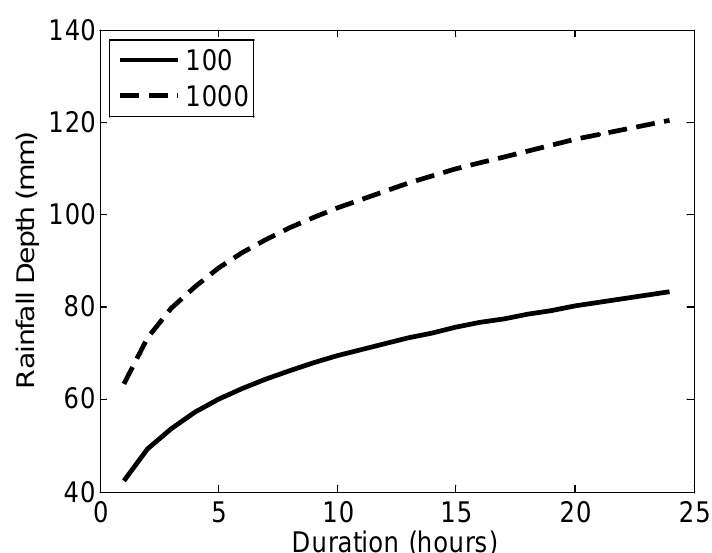
Figure 4. Rainfall DDF curves for 100 and 1000 years return periods (Overeem et al.,